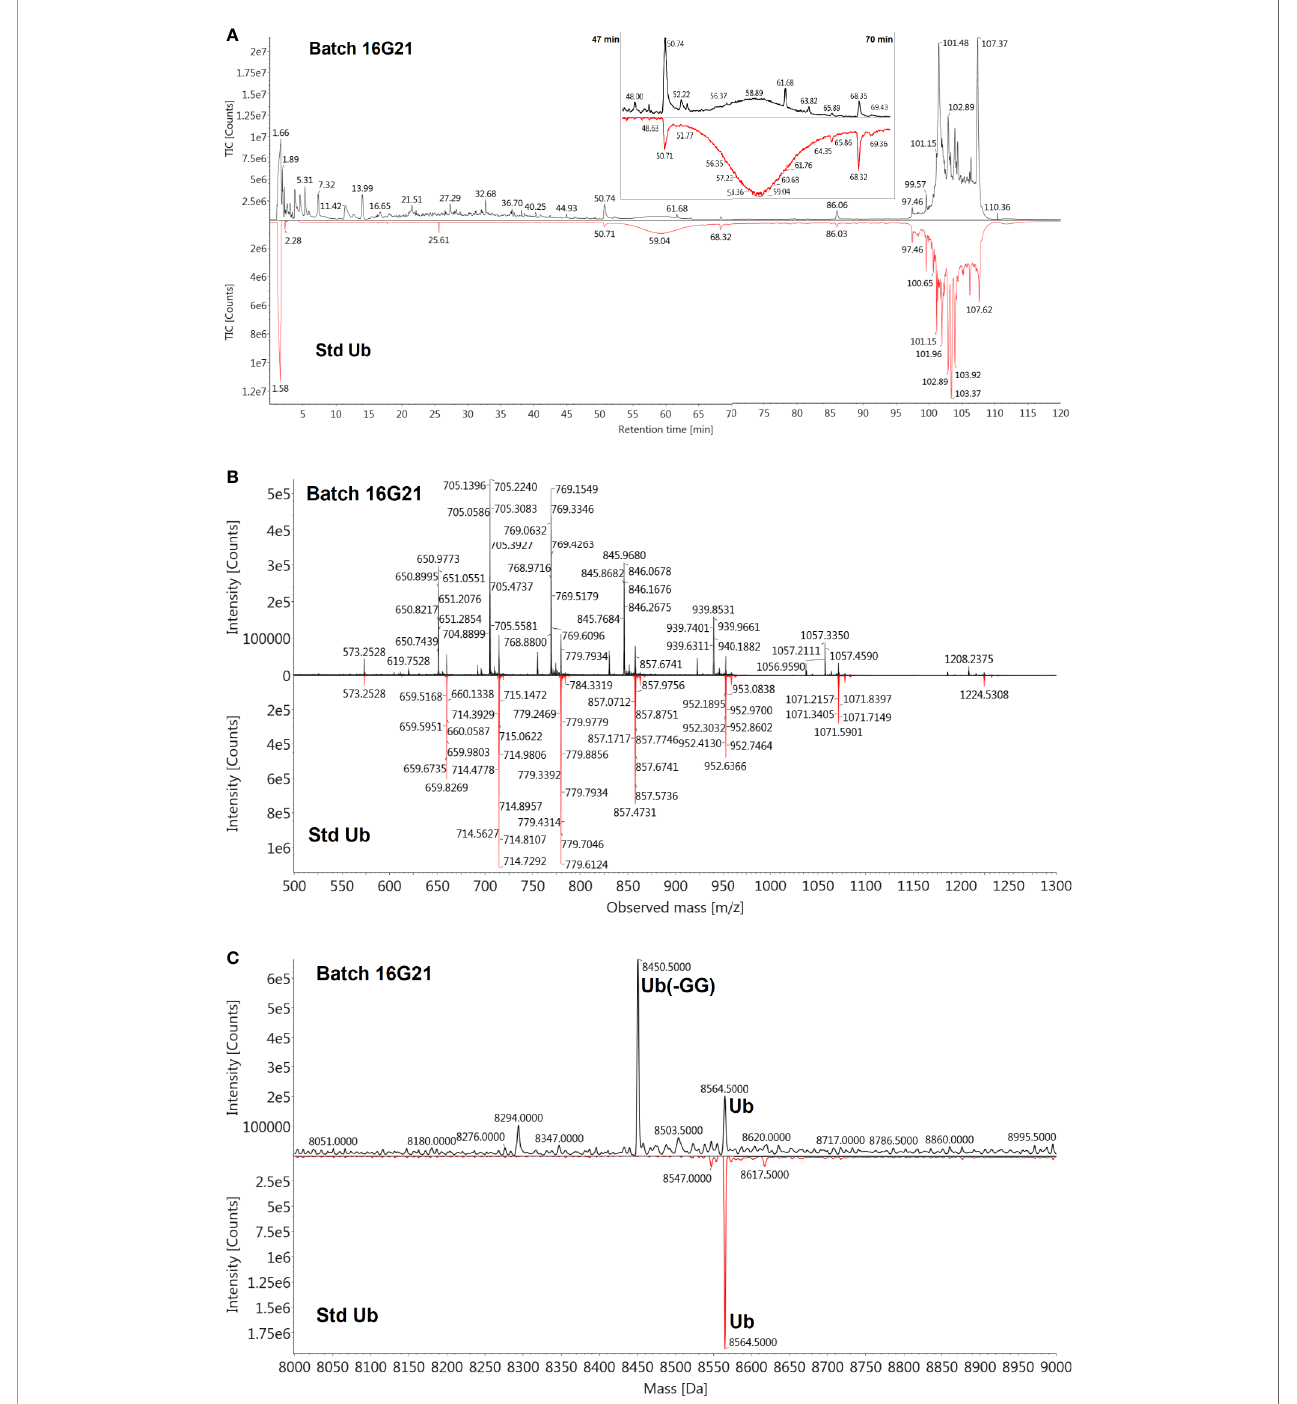
FIGURE 6 | Veri fi cation of the presence of Ub in Transferon and identi fi cation of Ub (-GG). (A) A monomeric standard of Ub (Std Ub) was analyzed by MS using a 3.0 µm BioSuite ® C18 column, along with the Transferon batch 16G21; both TIC pro fi les were similar from 47 to 70 min. (B) This segment of the TIC pro fi le was combined and the m/z signals between Transferon and SD Ub were also similar when compared in a mirror projection. (C) The deconvolution of the m/z pro fi les of Transferon exhibited two masses, the fi rs (8564.5 Da) corresponded to that of the Std Ub (8564.5 Da), whereas the second (8450.5 Da) to the theoretical mass value of monomeric Ub and monomeric Ub without two-terminal Gly [Ub(-GG); 8,450.74